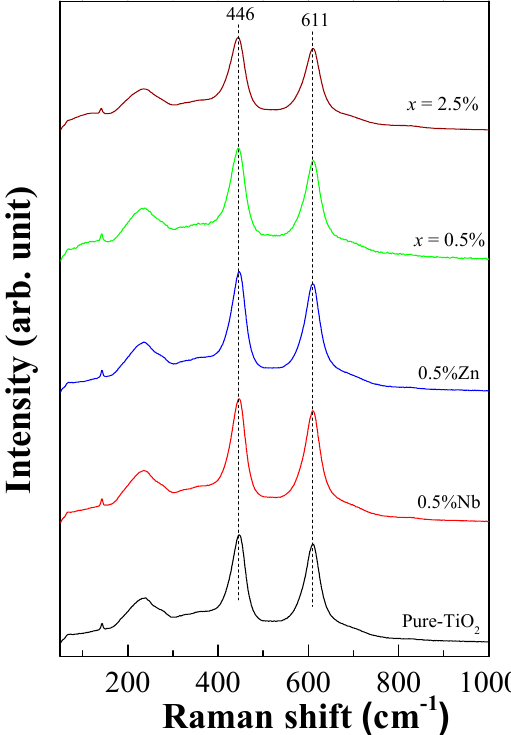
Figure 3. Raman spectra of rutile-TiO 2 , single doped of Nb 5+ and Zn 2+ and ZNTO ceramics with difference codoping levels.